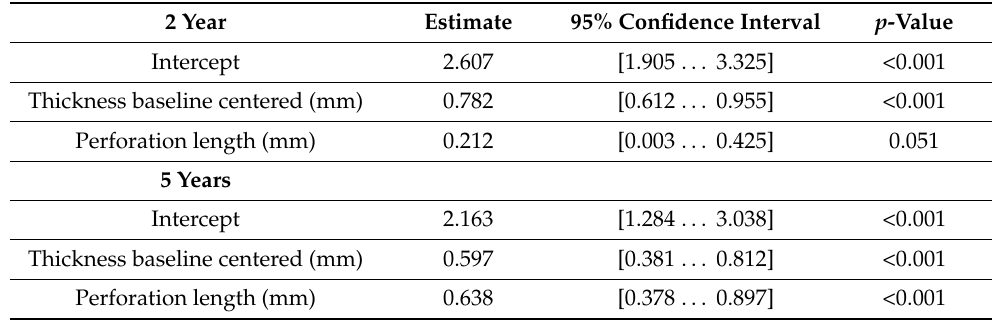
Table 2. Effect of perforation length and baseline swelling on membrane thickness after 2 and 5 years.